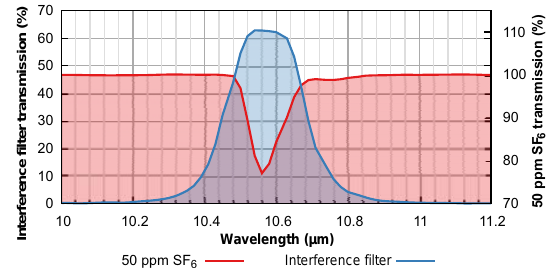
Figure 2. Transmission of the interference filter and absorption bands of SF 6 .